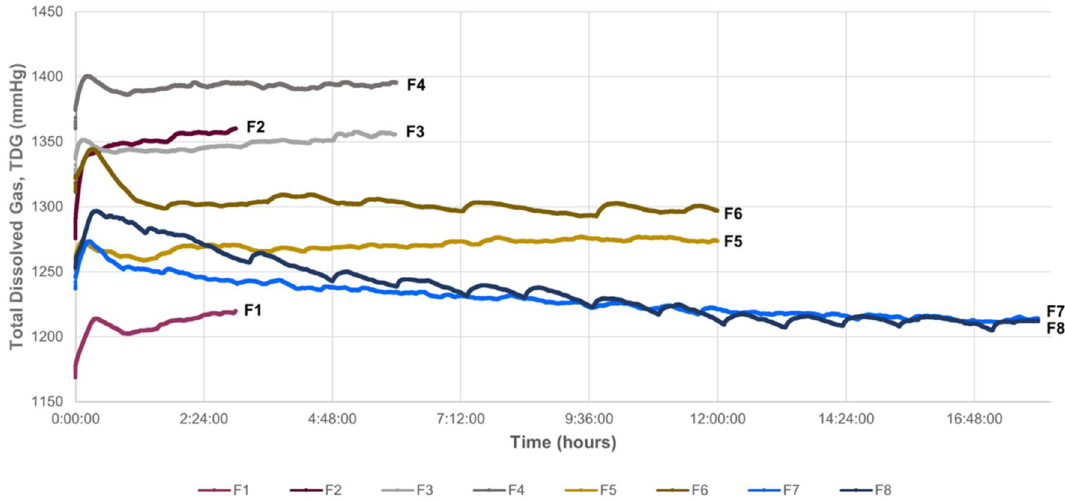
Figure 6. Representation of the evolution of TDG values from the introduction of the fish to the end of the exposure time for each experimental fish. F1-F2 correspond to the 3 h group, F3–F4 to the 6 h group, F5–F6 to the 12 h group, and F7–F8 to the 18 h model